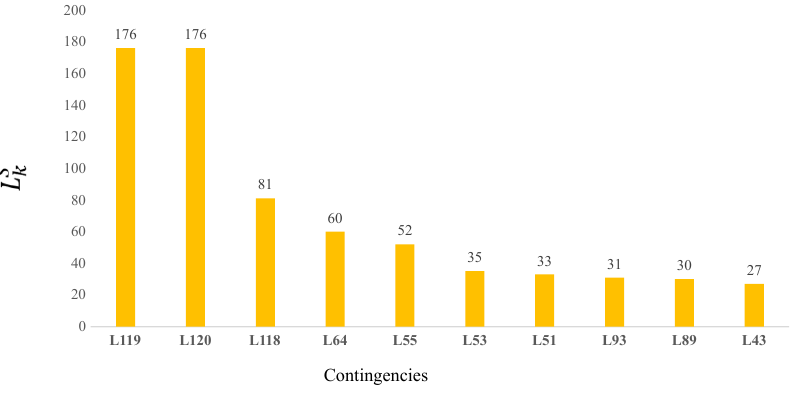
Figure 4. L S : The average number of lines l affected by contingency k . k